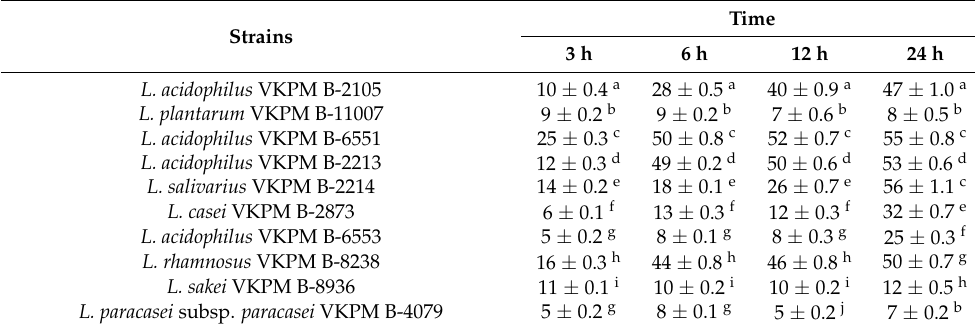
Table 11. Autoaggregation percentage of Lactobacillus